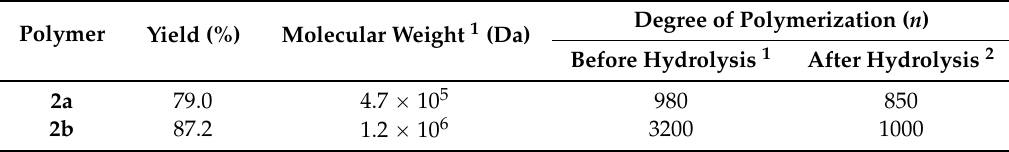
Table 1. Molecular weight of fluoroethylene glycol polymer ( 2a ) and fluoroalkyl polymer ( 2b ). Polymer